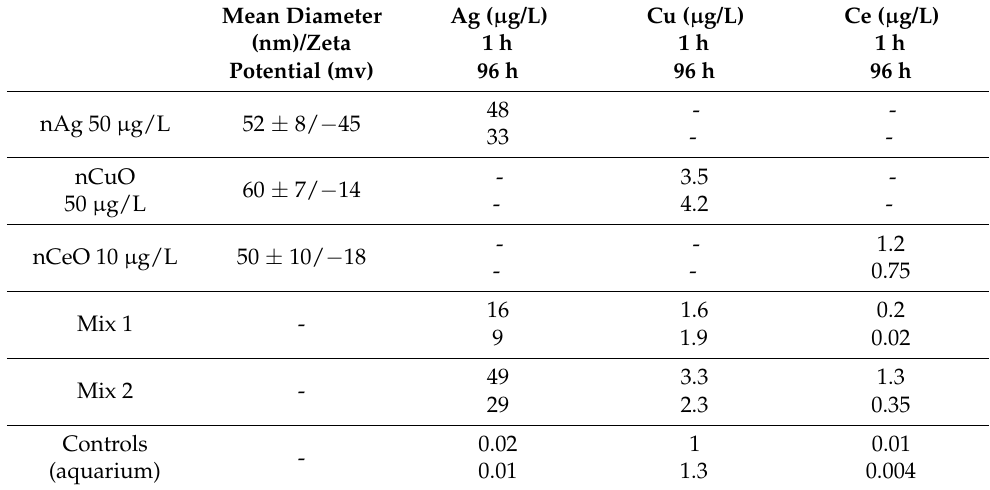
Table 1. The nominal concentration of nanoparticles in the exposure media.